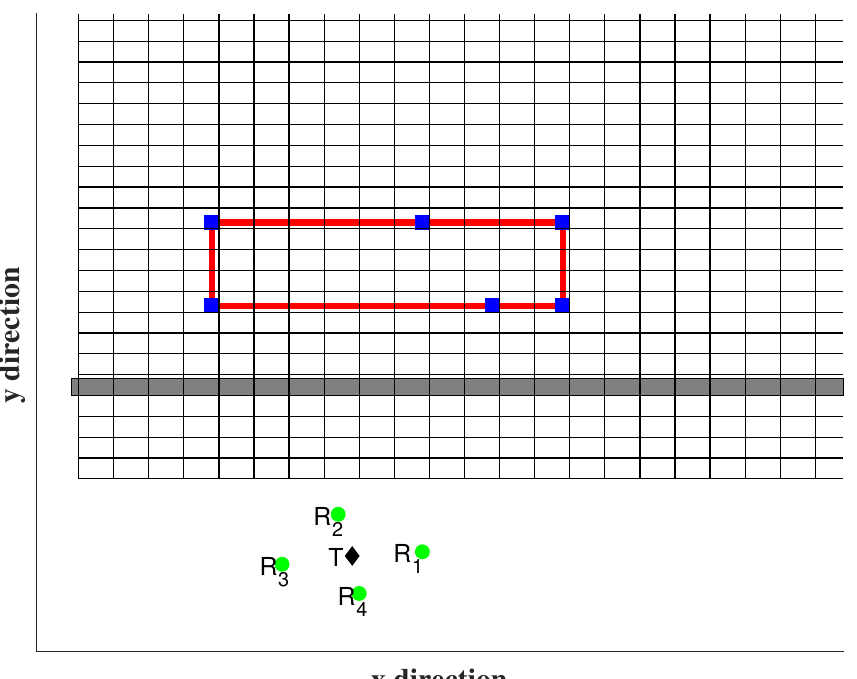
Figure 4. Figure showing imposing the grid over the area of interest. Figure 5 is plotted for the scenario in Figure 3 with height as the mass of the